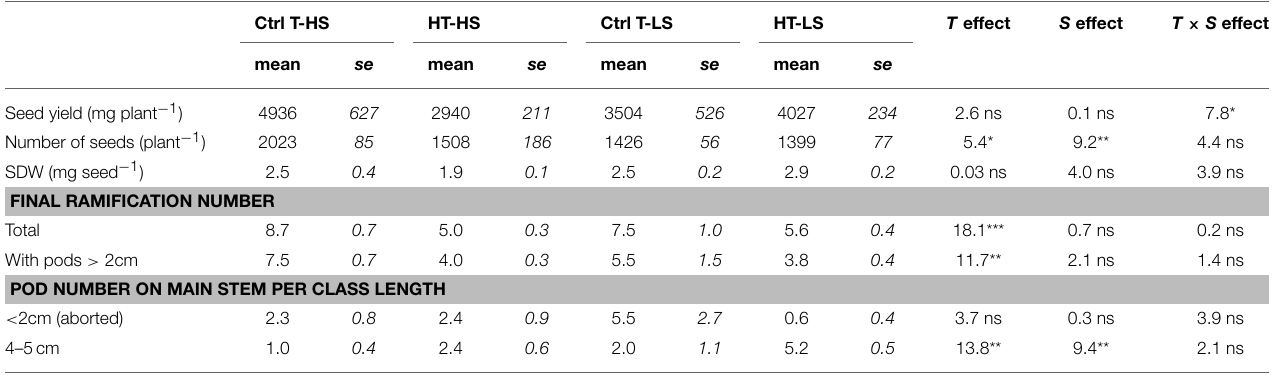
TABLE 1 | Mean values of yield components for the 4 modalities. Ctrl